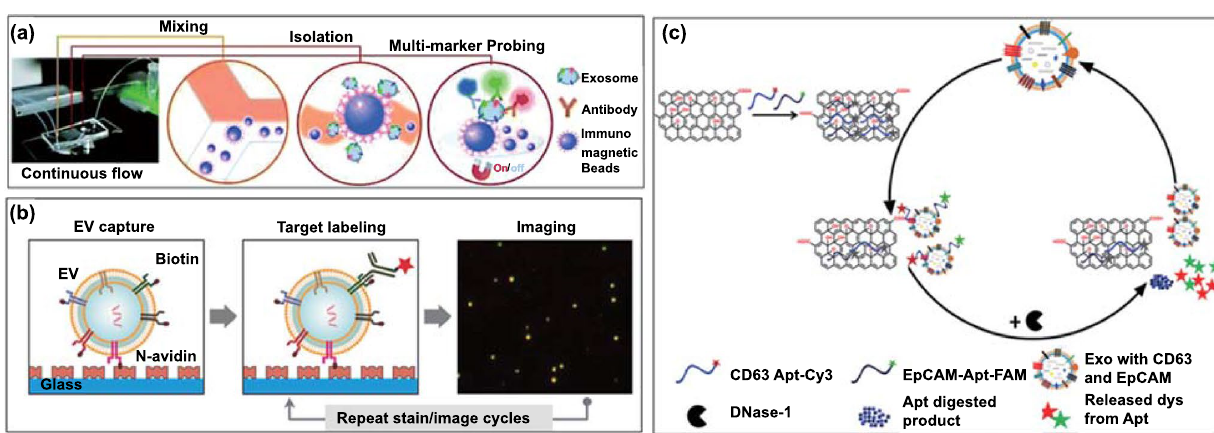
Fig. 4 Multiplexed profiling of EV proteins using fluorescent dye-based chemical coding strategy. a The ExoSearch chip for continuous mixing, isolation and in situ, multiplexed detection of circulating exosomal markers CA-125, EpCAM and CD24. Reproduced with permission from Ref.